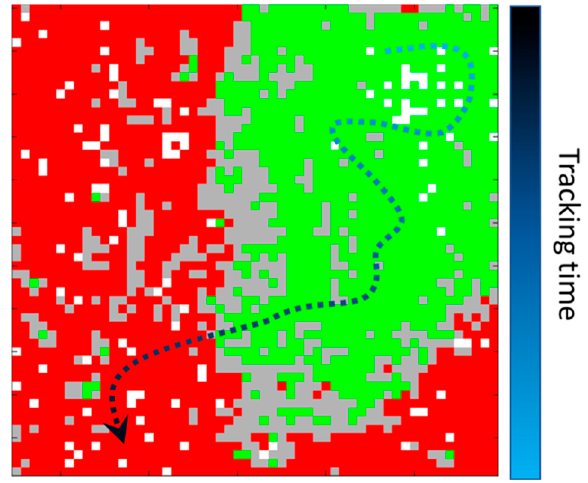
Figure 4. 2-D GTM map of a n-D space, colored on the basis of the unit composition, and trajectory of a disrupted pulse. The color bar shows the time evolution of the discharge, and its color darkens during the time up to the tip of the arrow representing the end point. All the synthesized features except LM norm , used to train the MLP-NN, have been used also to train the GTM model.